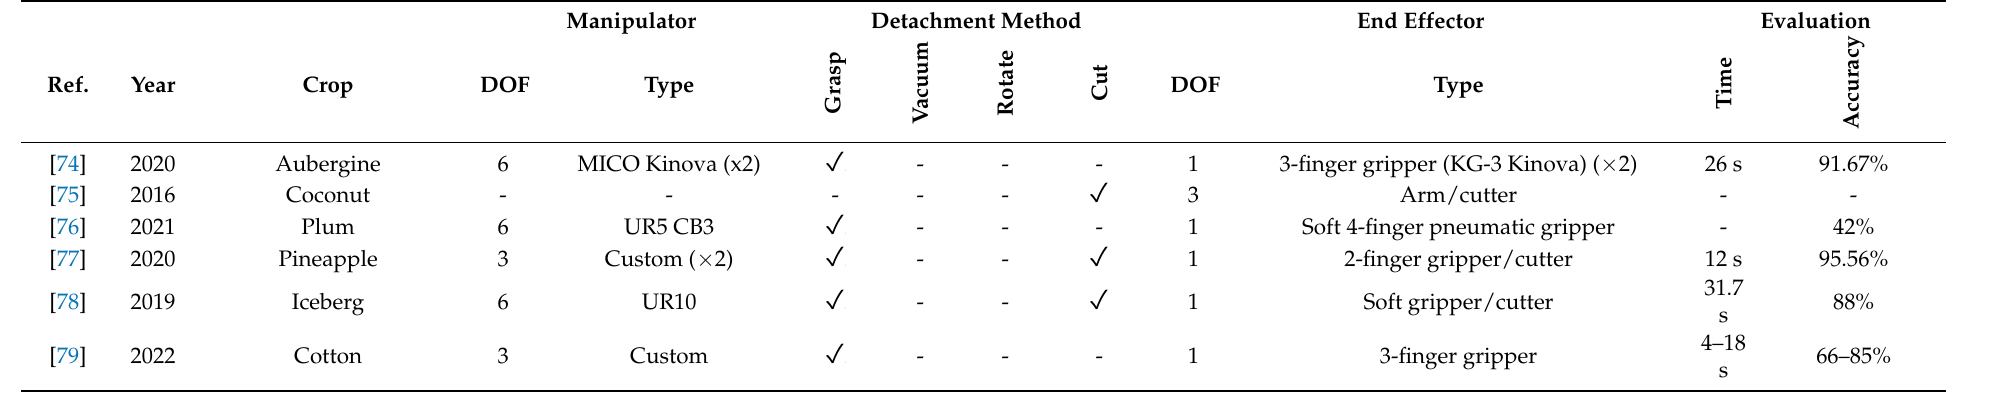
Table 1. Cont. Manipulator Detachment Method End Effector Evaluation Ref. Table 1. Ground robotic manipulation systems for harvesting. Evaluation metrics of harvesting cycle time (time) and detachment success rate (accuracy) are included. Grasping from the stem is Table 1. Ground robotic manipulation systems for harvesting. Evaluation metrics of harvesting cycle time (time) and detachment success rate (accuracy) are included. Grasping from the stem is marked with “ ✓ s”; all other cases refer to direct contact grasping of the fruit. - Table 1. Ground robotic manipulation systems for harvesting. Evaluation metrics of harvesting cycle time (time) and detachment success rate (accuracy) are included. Grasping from the stem is marked with “ ✓ s”; all other cases refer to direct contact grasping of the fruit. 3 Arm/cutter - - Table 1. Ground robotic manipulation systems for harvesting. Evaluation metrics of harvesting Table 1. Ground robotic manipulation systems for harvesting. Evaluation metrics of harvesting cycle time (time) and detachment success rate (accuracy) are included. Grasping from the stem is cycle time (time) and detachment success rate (accuracy) are included. Grasping from the stem is marked with “ ✓ s”; all other cases refer to direct contact grasping of the fruit. Table 1. Ground robotic manipulation systems for harvesting. Evaluation metrics of harvesting Table 1. Ground robotic manipulation systems for harvesting. Evaluation metrics of harvesting marked with “ ✓ s”; all other cases refer to direct contact grasping of the fruit. marked with “ ✓ s”; all other cases refer to direct contact grasping of the fruit. cycle time (time) and detachment success rate (accuracy) are included. Grasping from the stem is Table 1. Ground robotic manipulation systems for harvesting. Evaluation metrics of harvesting marked with “ ✓ s”; all other cases refer to direct contact grasping of the fruit. cycle time (time) and detachment success rate (accuracy) are included. Grasping from the stem is marked with “ ✓ s”; all other cases refer to direct contact grasping of the